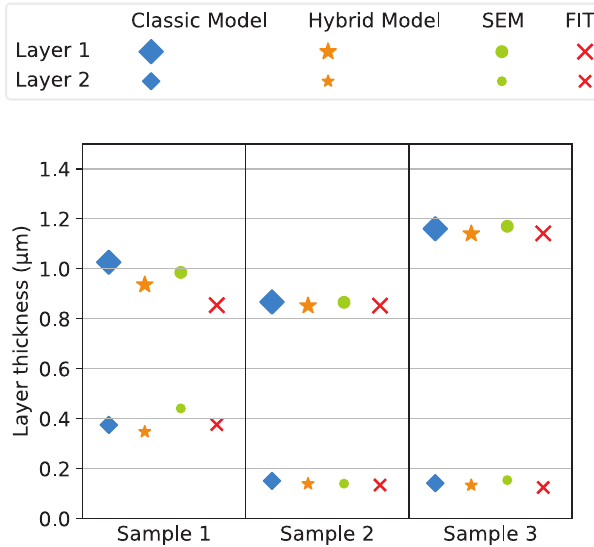
Fig. 9. Comparison of the thickness predicted with the classic and the hybrid model and the values evaluated from SEM